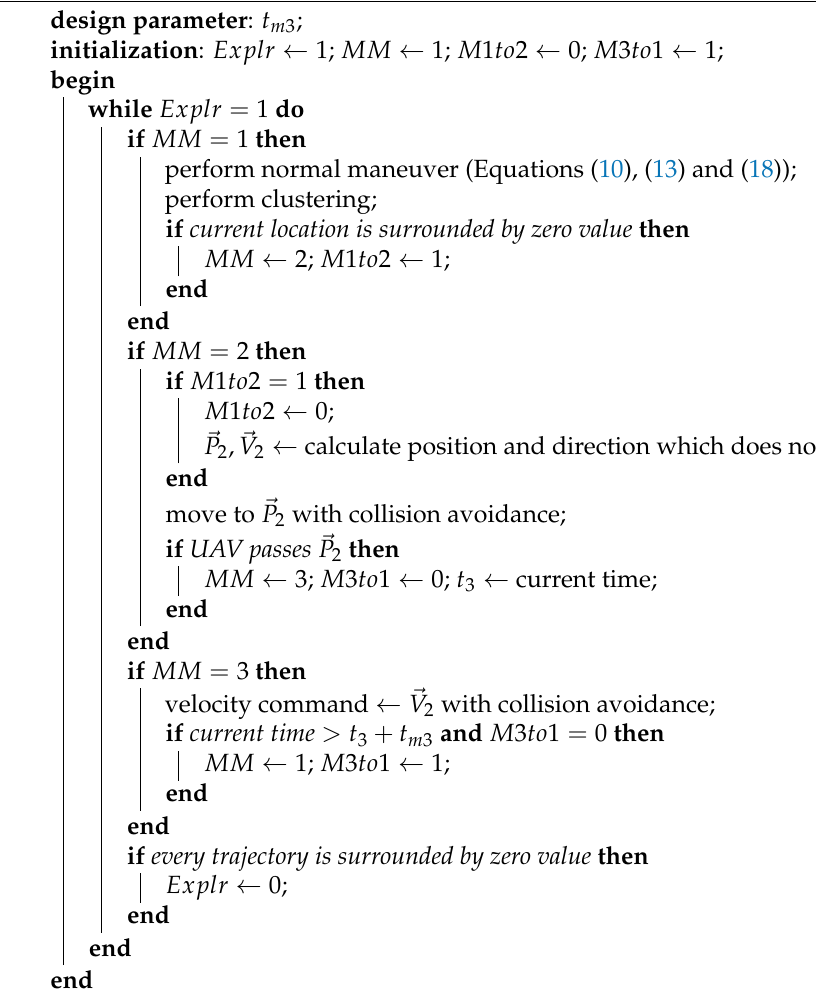
Algorithm 1: Overall strategy including dead-end